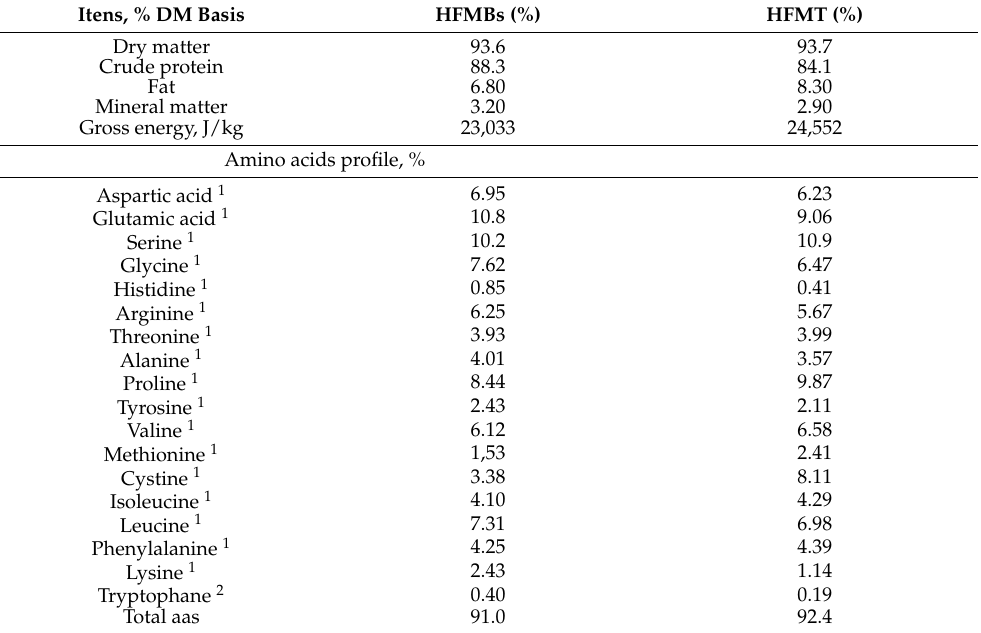
Table 2. Chemical composition and amino acid profile of hydrolyzed feather meal by Bacillus subtilis (HFMBs) and thermally hydrolyzed feather meal (HFMT) expressed in dry matter basis. Itens, % DM Basis HFMBs (%) HFMT (%) Dry